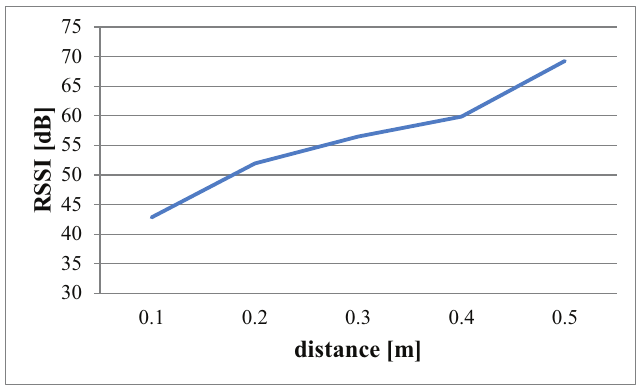
Figure 6. Overall path loss in underwater environment.